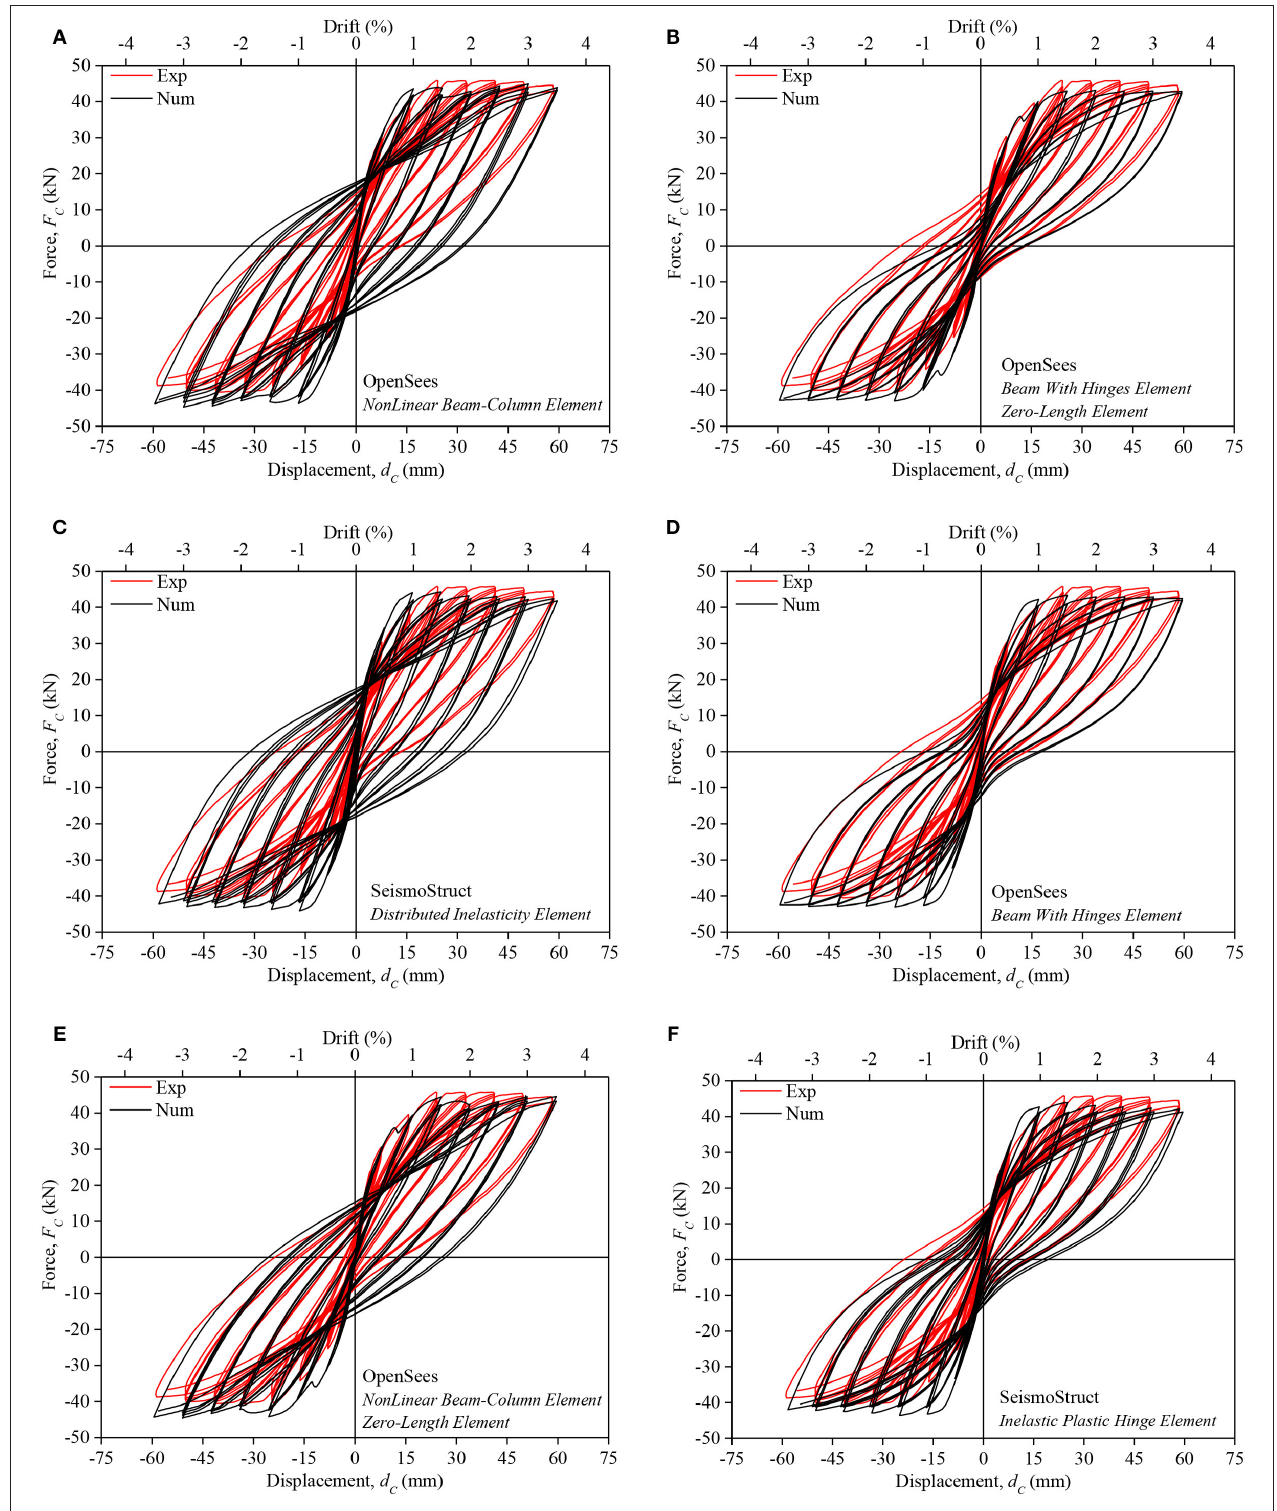
FIGURE 5 | Experimental and numerical force-drift relationship comparison of specimen CD: (A–C) numerical results considering elements with distributed plasticity; (D–F) numerical results considering elements with plastic hinges.